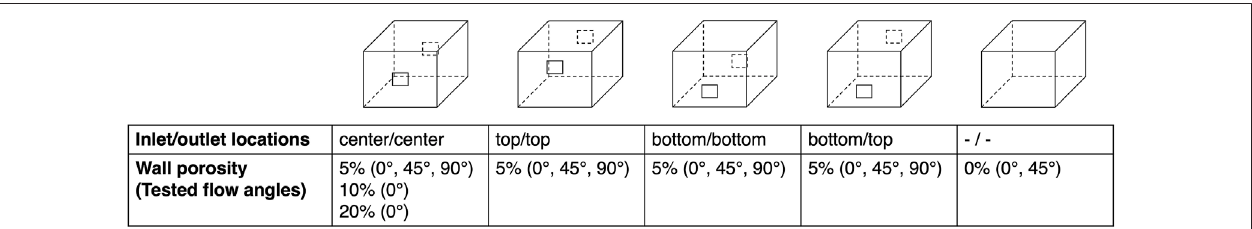
FIGURE 3 | Ventilation con fi gurations considered in the current